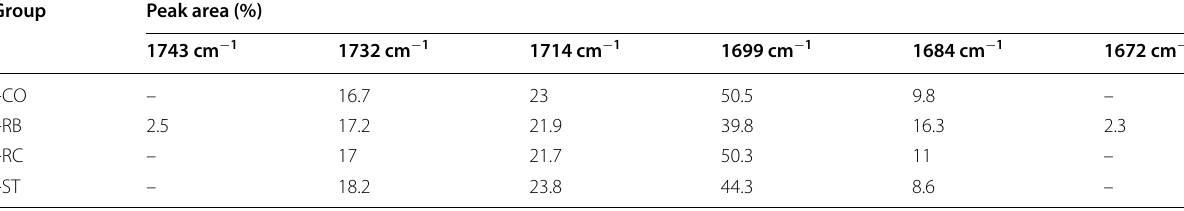
Table 5 The results of the curve-fitting analysis of the ester peak for Invisalign